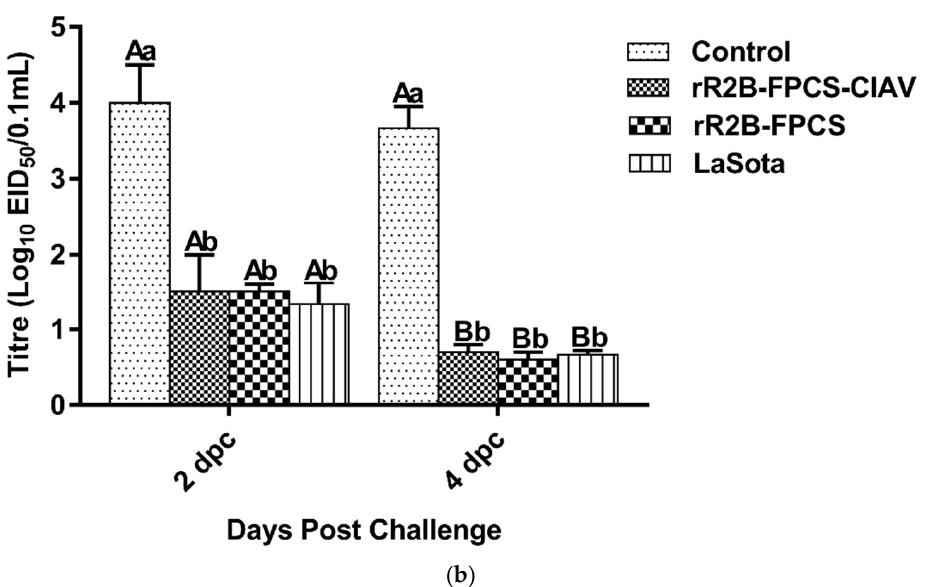
Figure 8. The effect of vaccination on virus shed in comparison to unvaccinated control group. Swabs ( a ) oropharyngeal and ( b ) cloacal were tested for isolation of virus on 2 and 4 dpc from the experimental birds. The virus shedding decreased significantly in the vaccinated groups by 4 dpc while the control birds were dead at the same time. Different capital letter superscripts indicate time effect ( p < 0.0001) while the small letter superscripts indicate the treatment effect ( p < 0.0001).